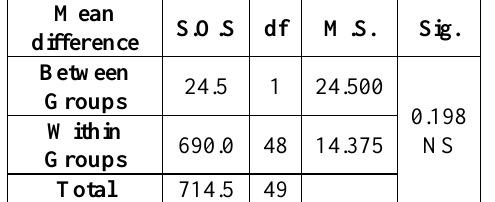
Figure 1: The Mean Protrusive Angles Verified byTMJ & Hanau H-2 Articulators & the Mean Differences of Females & Males (in degrees). Table 4: ANOVA Test Results of the Difference in Protrusive Angle Means Verified by TMJ & Hanau H-2 Articulators.